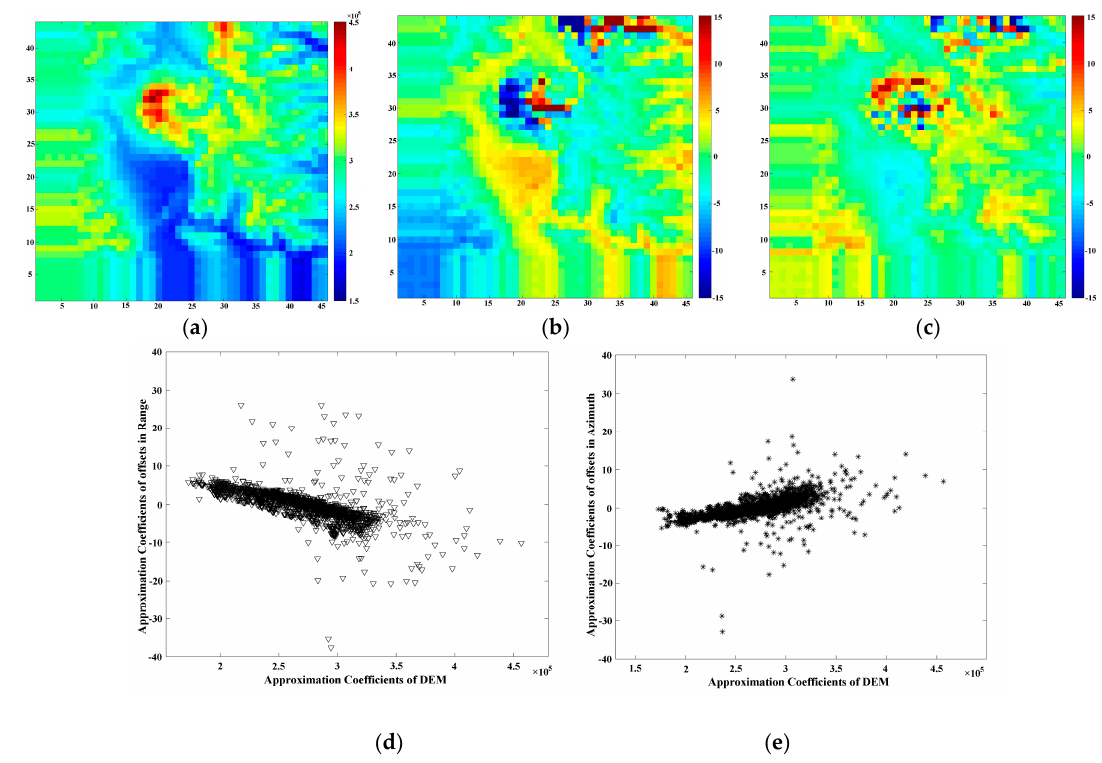
Figure 4. The correlation analysis of the signal in the wavelet domain: ( a – c ), are the wavelet-reconstructed parts of the DEM, range, and azimuth offset fields, respectively; ( d ) is the correlation of the approximation coefficients between the DEM and range offset field; and ( e ) is the correlation of the approximation coefficients between the DEM and azimuth offset field.